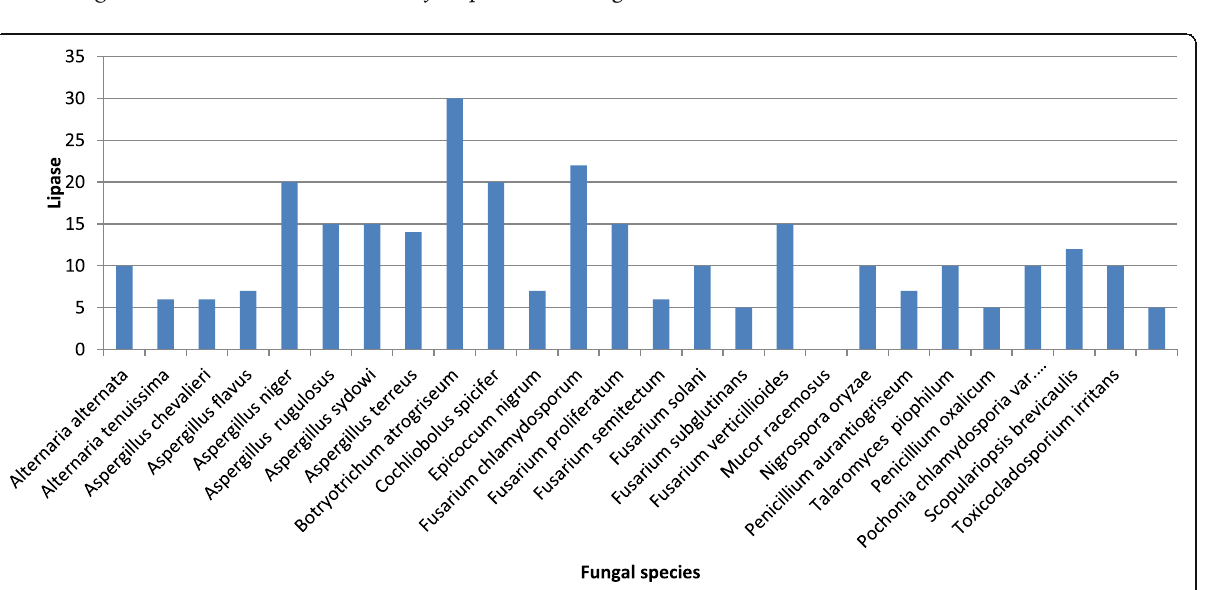
Fig. 1 Lipase activity of fungal species isolated from